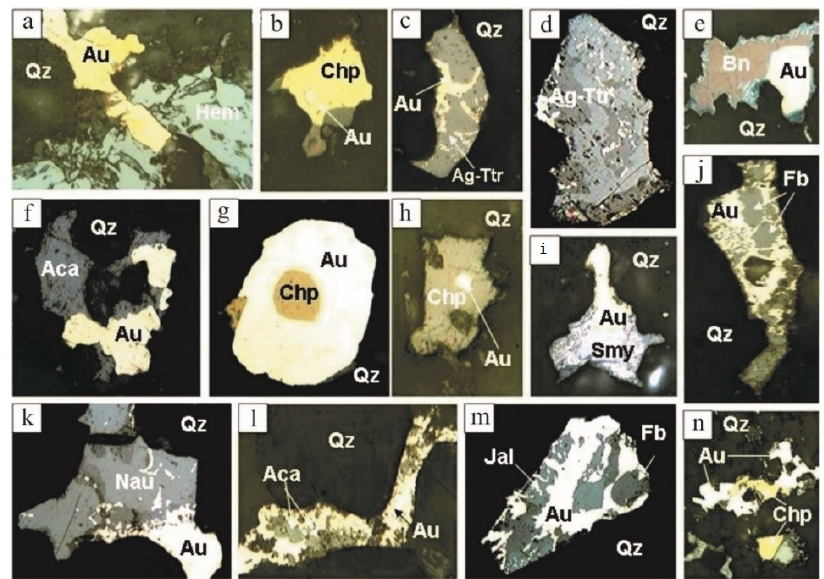
Figure 10. Types of intergrowths of native gold with ore minerals in quartz-sericite vein material at the Olcha deposit: ( a ) gold with hematite; ( b ) inclusion of kustelite in chalcopyrite; ( c ) close intergrowths of gold with argentotetrahedrite; ( d ) vein-like intergrowths of gold with argentotetrahedrite; ( e ) gold with bornite; ( f ) gold with acanthite; ( g ) inclusion of chalcopyrite in gold; ( h ) inclusion of gold in chalcopyrite; ( i ) intergrowth of gold with acanthite and stromeyerite; ( j ) gold with freiber- gite; ( k ) complex intergrowth of gold with naumannite and stromeyerite; ( l ) gold with acanthite; ( m ) gold-freibergite + jalpaite; ( n ) gold with chalcopyrite. (All taken at 100 ×